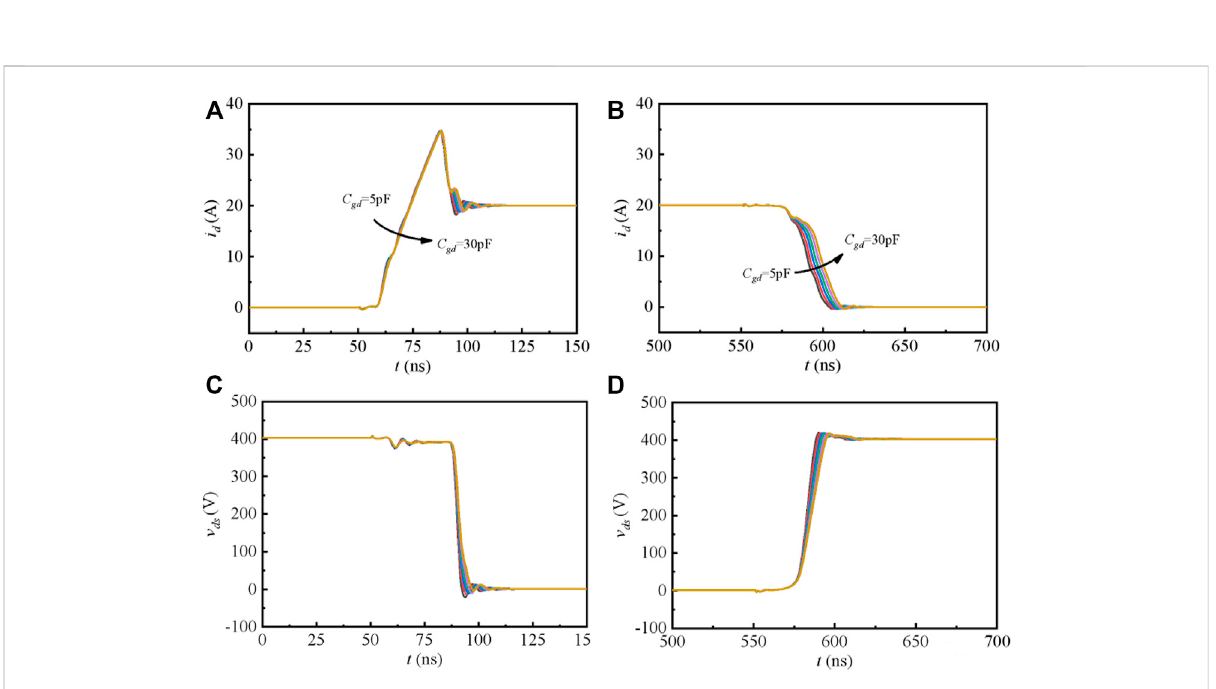
FIGURE 8 In fl uence of C gd on the switching behavior of the SiC MOSFET. (A) Turn-on i d . (B) Turn-off i d . (C) Turn-on u ds . (D) Turn-off u ds